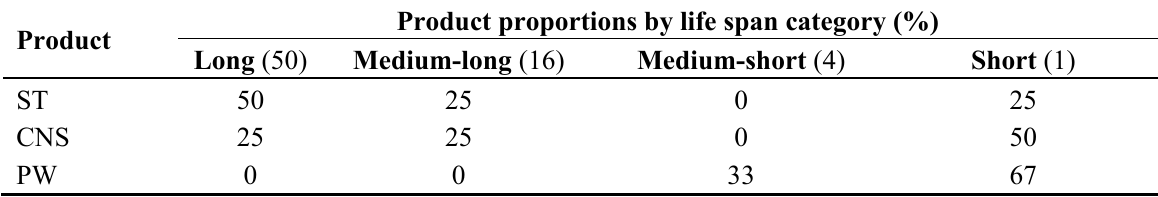
Table 2. Proportions of wood products by life-span